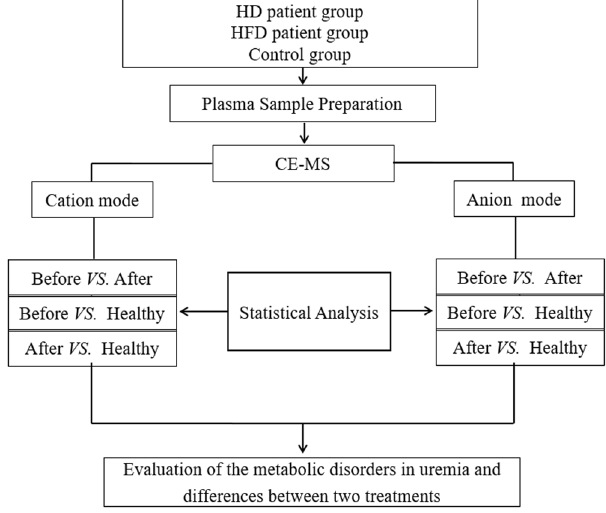
Figure 1. Flow chart used to display the whole process of the metabolomics